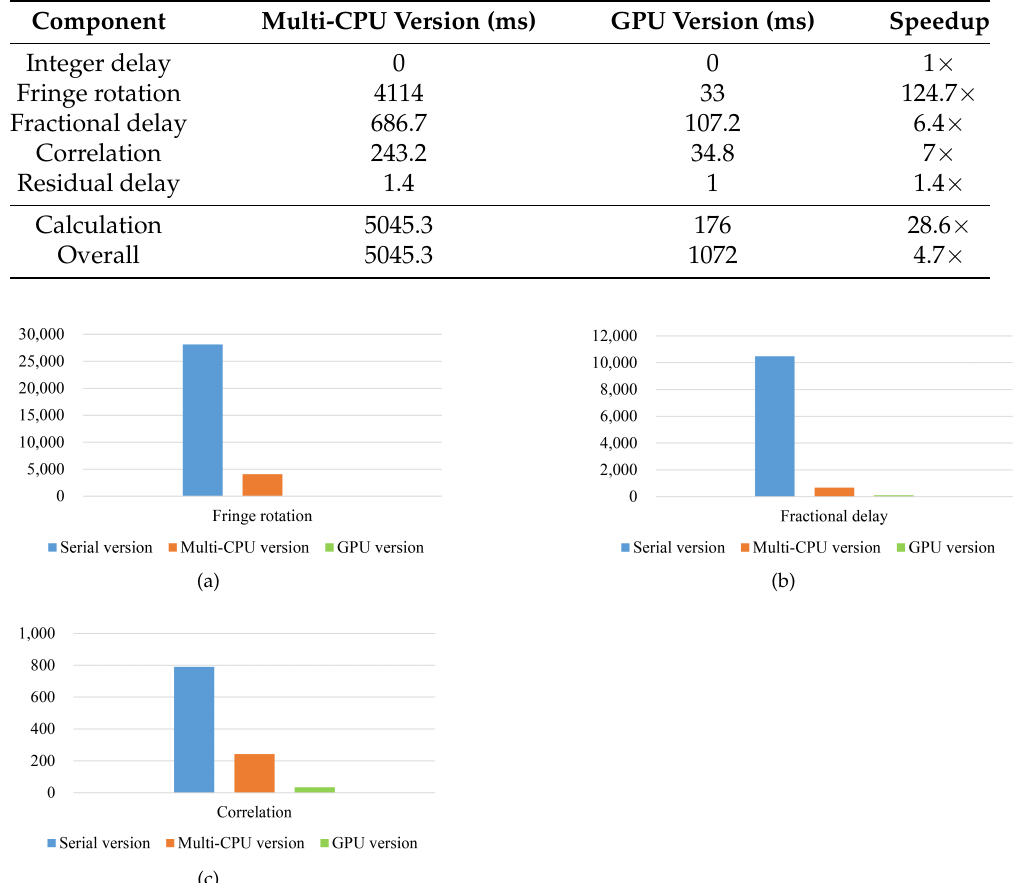
Table 4. The comparison between GPU version and message passing interface (MPI) version.